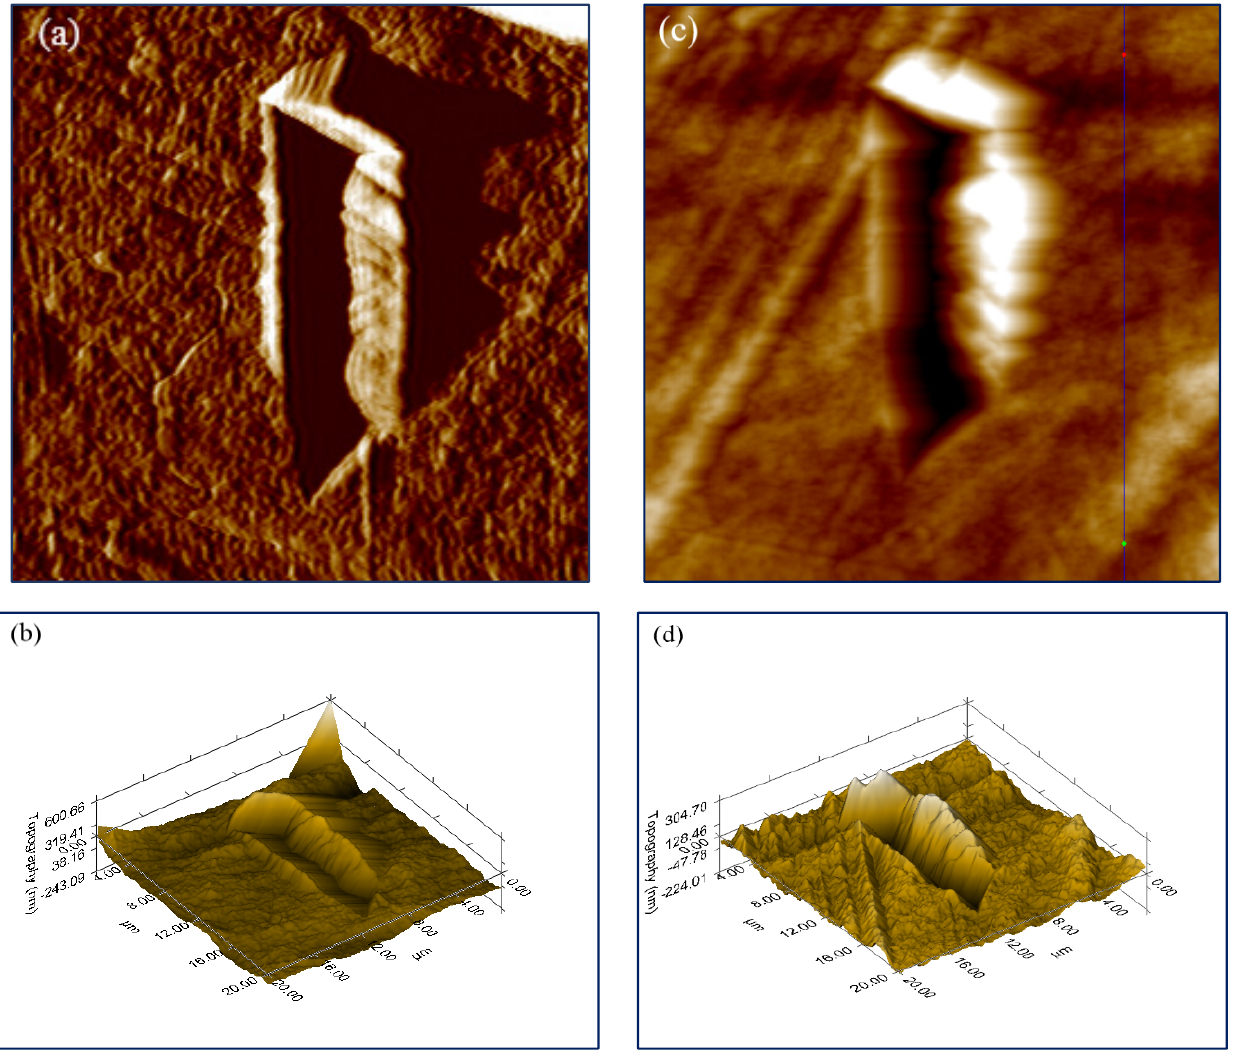
Figure 7. In-situ SPM images of gradient forward ( a ) and 3D ( b ) scans over 20 µ m × 20 µ m sur- Figure 7. In ‐ situ SPM images of gradient forward ( a ) and 3D ( b ) scans over 20 μ m × 20 μ m surface face area of nanoscratched 3 wt%GNP3 wt%MWCNT/PLA composite sample, and topography area of nanoscratched 3 wt%GNP3 wt%MWCNT/PLA composite sample, and topography forward forward ( c ) and 3D ( d ) scans over 20 µ m × 20 µ m surface area of nanoscratched 6 wt%GNP/PLA ( c ) and 3D ( d ) scans over 20 μ m × 20 μ m surface area of nanoscratched 6wt%GNP/PLA composite composite sample. Table 1. Average surface roughness received by in ‐ situ SPM imaging of nanocomposite surface area subjected to nanoscratch testing.